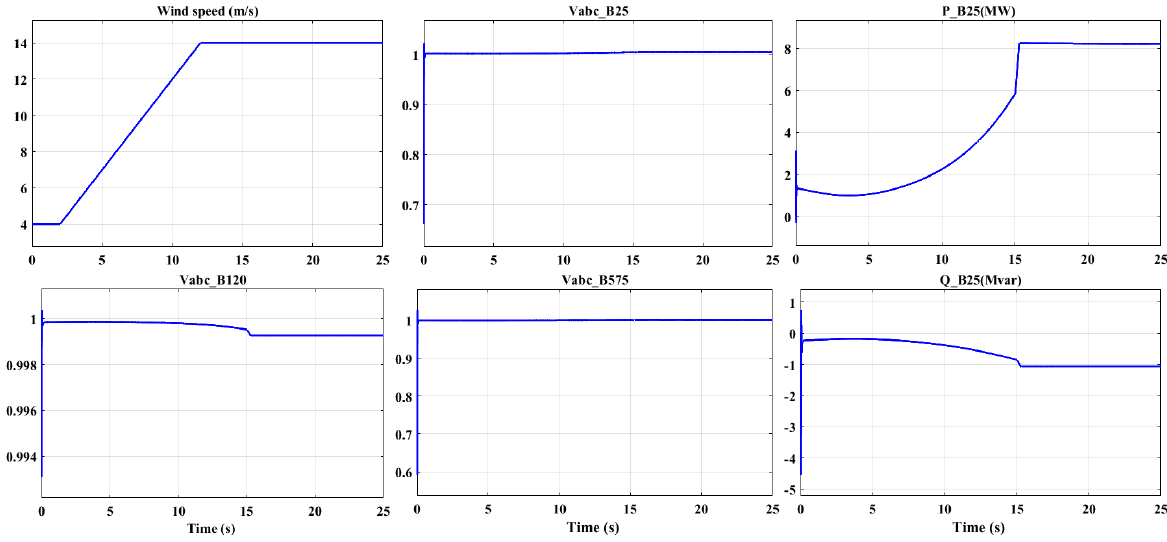
Figure 13. DFIG gird parameters at steady-state operation condition.